Question: How would you classify this visualization?
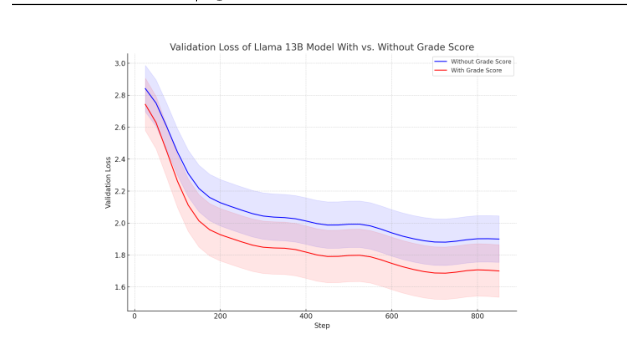
Answer: line